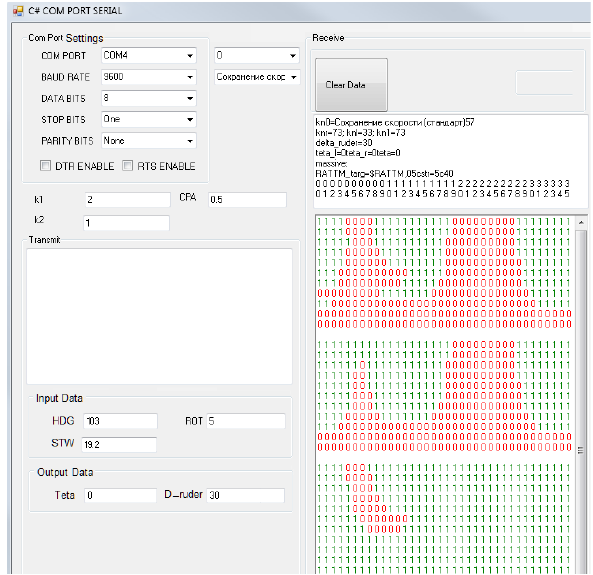
Fig. 8. Interface of information exchange software.